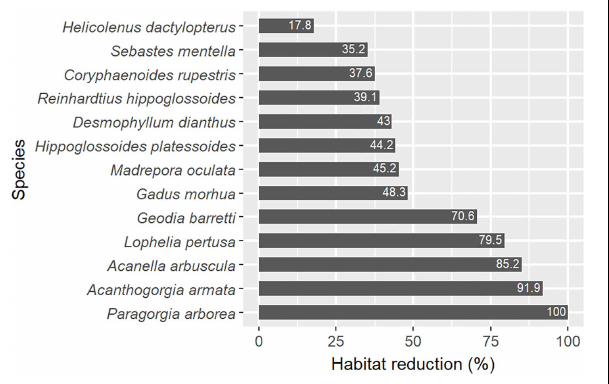
FIGURE 3 | Relative habitat reduction between present suitable habitat and future climate refugia for the 13 selected